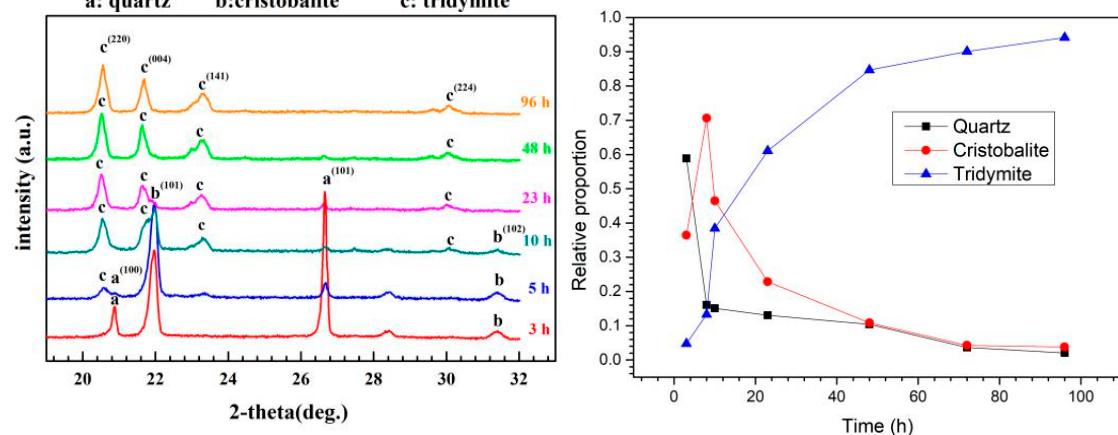
Figure 4. Phase evolution of coarse quartz—potassium silicate glass composites after holding at 1000 °C for different time.